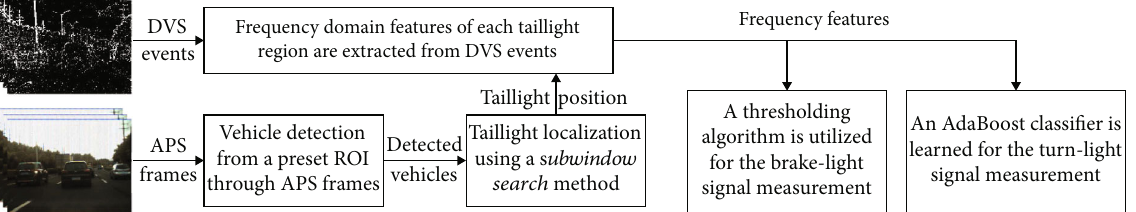
Figure 4: Schematic fl owchart of the proposed